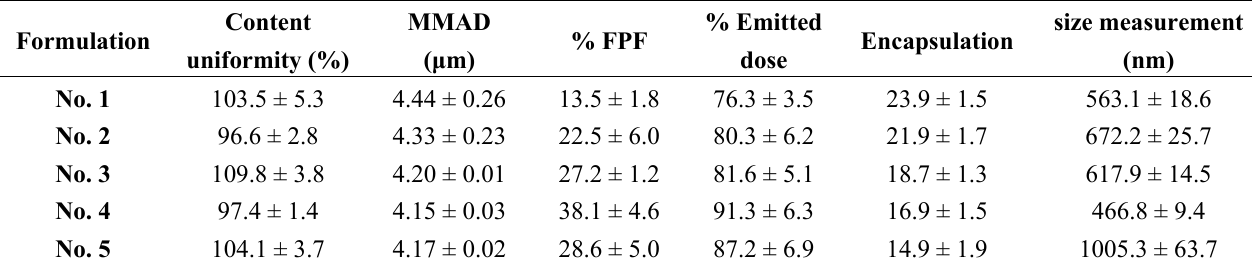
Table 1. Levofloxacin (LEV)-proliposome formulations and their aerosolization properties (mean ± SD, n =